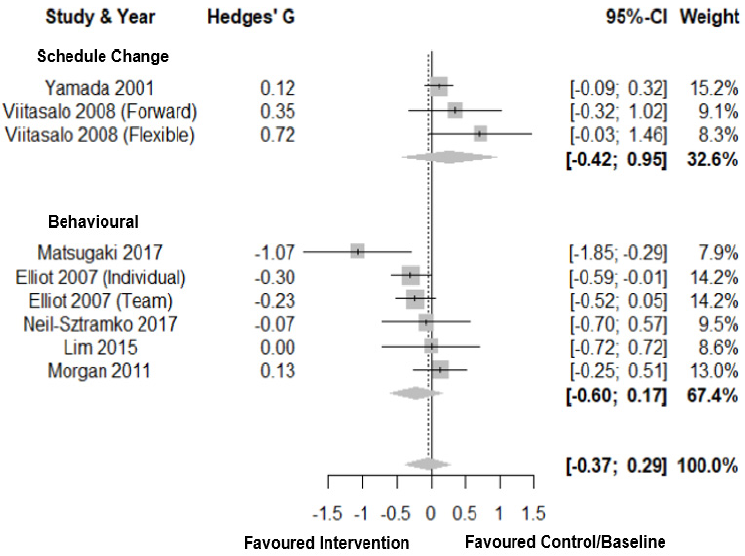
Figure 4. Forest plot for intervention by type on body mass index. Note. Interventions with multiple conditions are denoted within brackets.